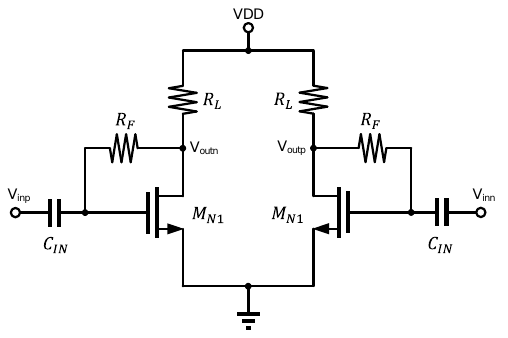
Figure 4. Schematic of the 50 Ω terminated shunt-feedback buffer.